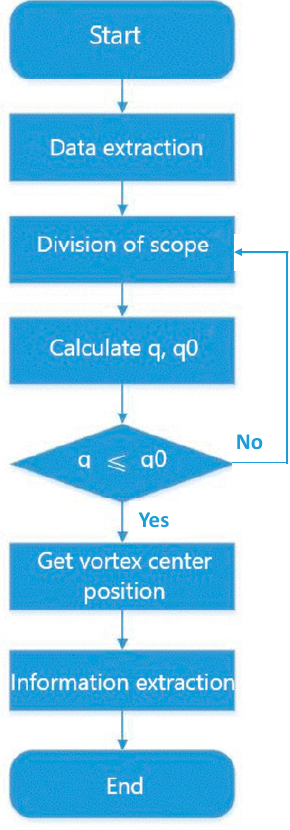
Figure 2. Flow chart of the OW algorithm.